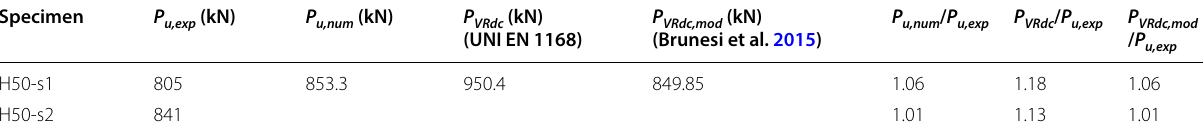
Table 3 Comparison between experimental, numerical and analytical results in terms of shear capacity for slabs H50-s1 and